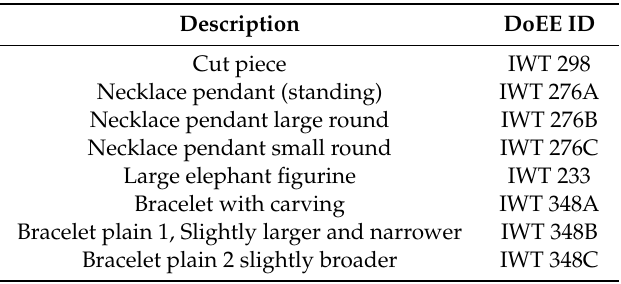
Table 1. Sample identifiers for volatile organic compound (VOC) and deoxyribonucleic acid (DNA) analysis of the seized unknown objects.